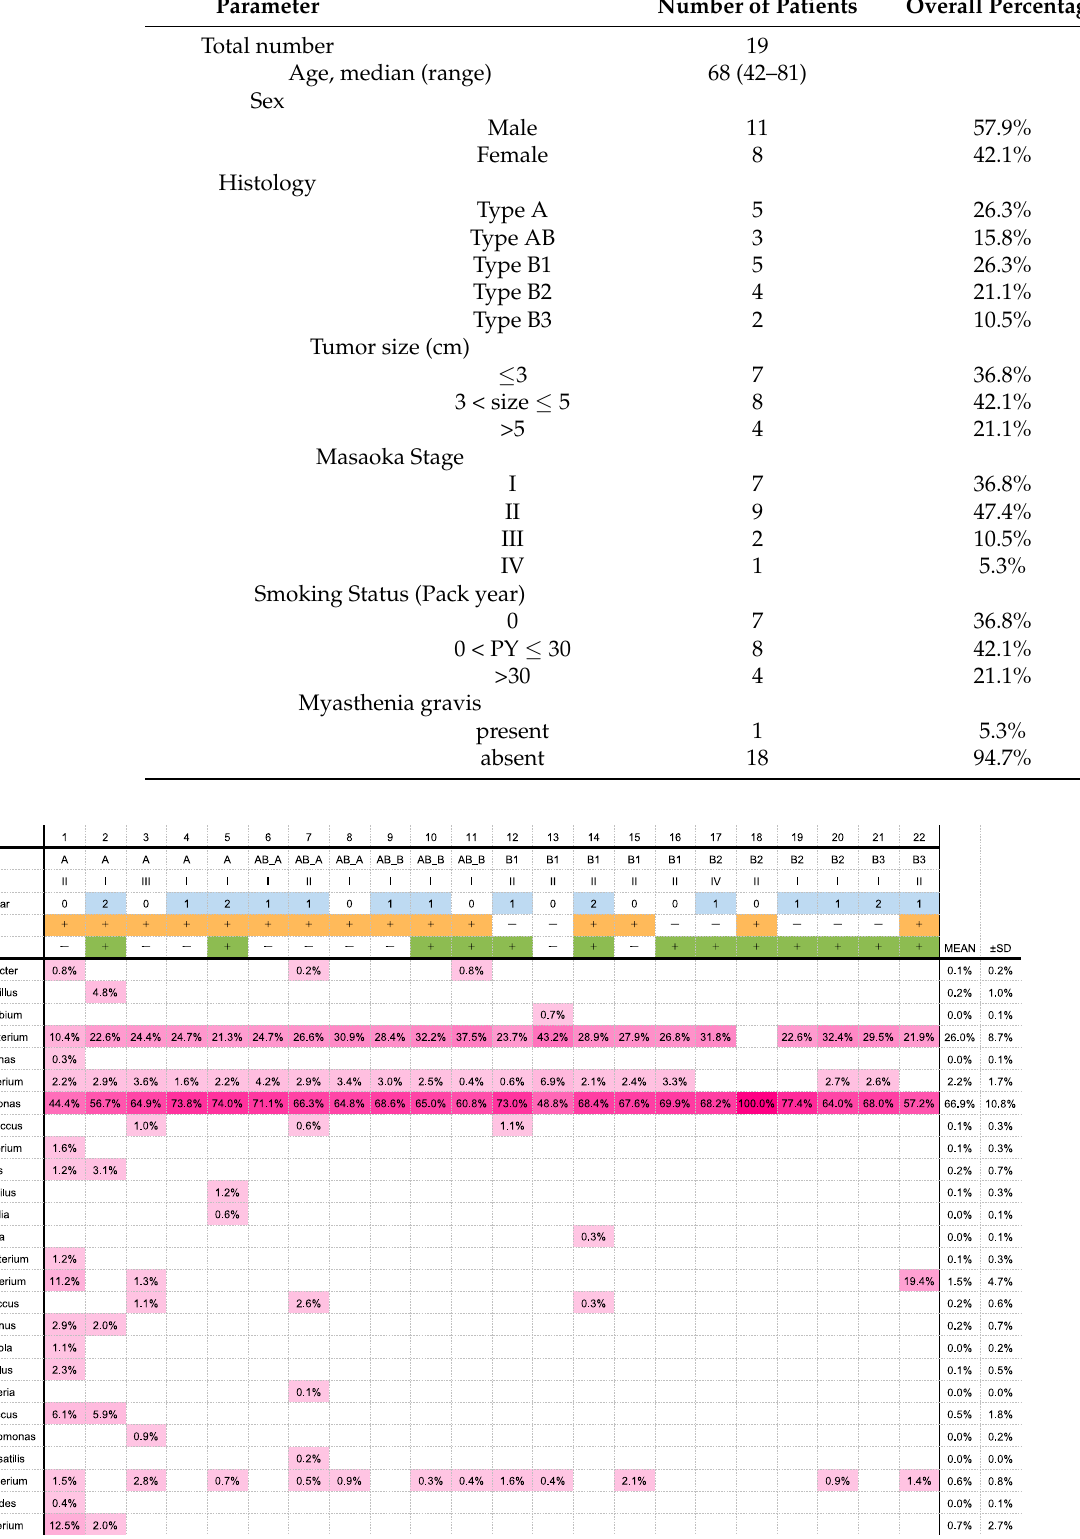
Figure 1. Composition and abundance of the dominant genera in all the samples. In total, 26 genera were identified. The heatmap visualizes the abundance of the detected genera. PY (pack-year) 0 represents nonsmokers; PY1, smokers with >0 to ≤ 30 packs/year history; and PY2, smokers with >30 packs/year history.